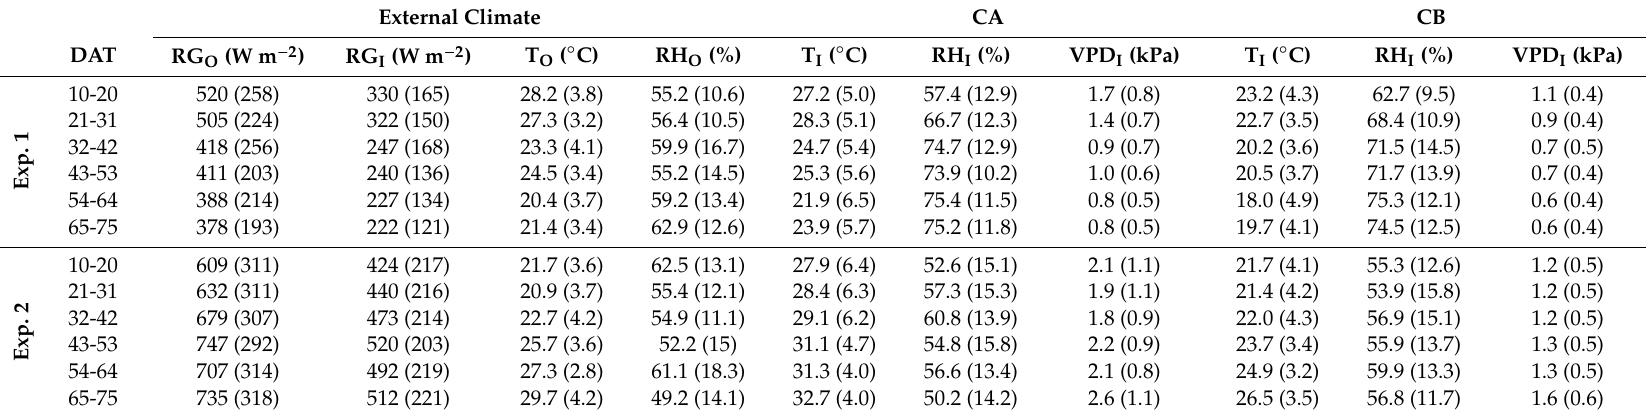
Table 1. Mean values ( ± standard deviation) of inside microclimate greenhouse and external greenhouse climatic data for daylight hours for Exp. 1 (autumn–winter crop) and Exp. 2 (spring